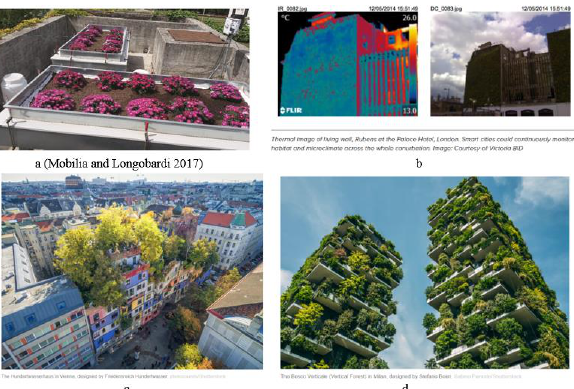
Figure 1. Examples for Biophilic design within smart sustainable city a) green roof, b) living wall, c and d) vertical greening